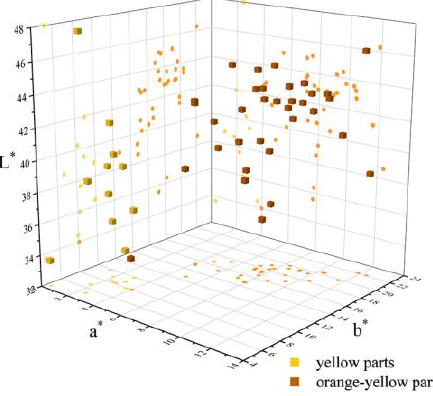
Figure 8. A 3D scatter diagram of yellow and orange-yellow areas in the yellow seal stone samples from Northern Laos. L* (Lightness) is the z-axis, a* (redness) is the x-axis, and b* (yellowness) is the y-axis.